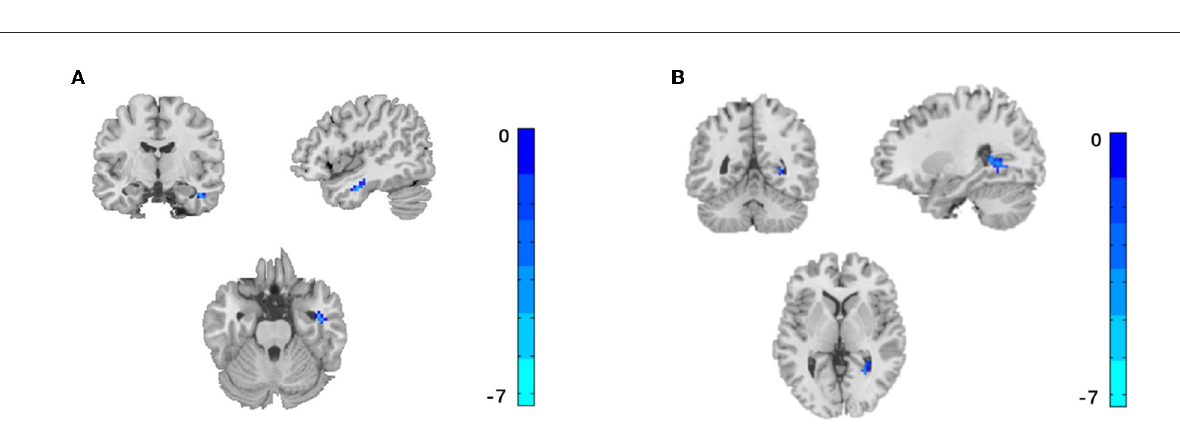
after acupuncture. The data of rs-fMRI after acupuncture was collected 2 days after 10 times of acupuncture